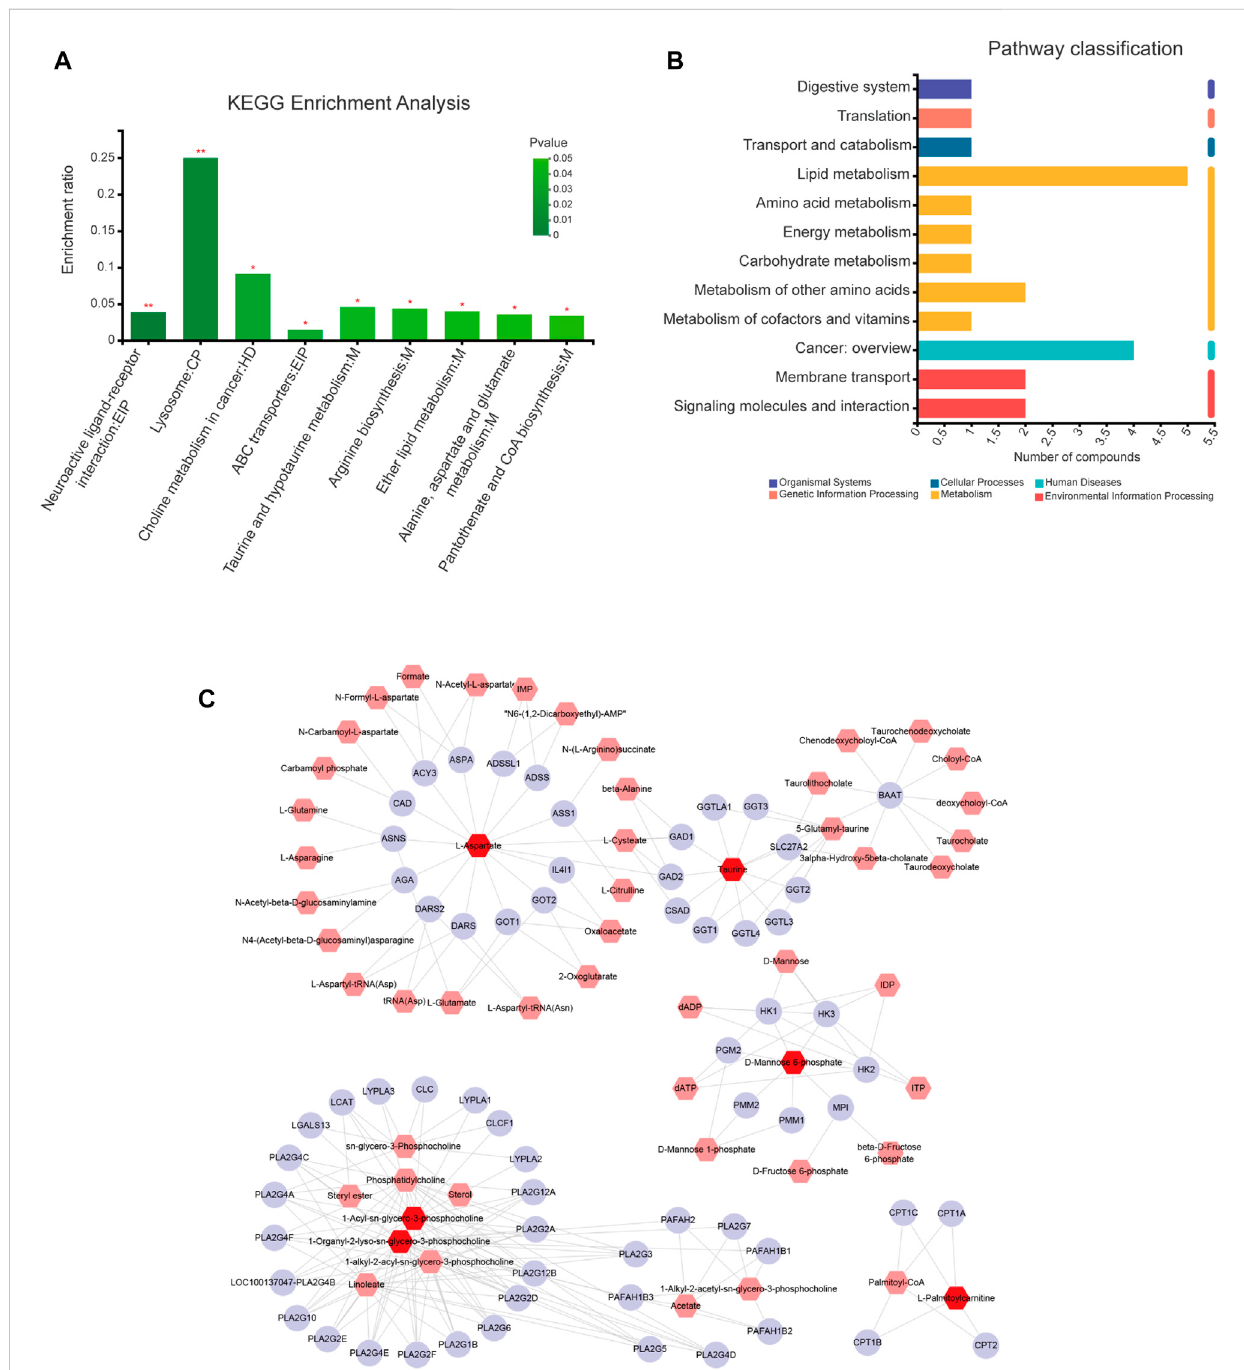
FIGURE 6 Pathway and network analyses of differential metabolites. (A) KEGG enrichment analysis of differential metabolites. (B) KEGG classi fi cation analysis of differential metabolites. (C) “ Metabolite-gene ” network for anti-fatigue effects of ginsenoside Rg1. Red, pink, and purple nodes represent differential metabolites, interacting metabolites, and interacting proteins, respectively. The edges represent biochemical